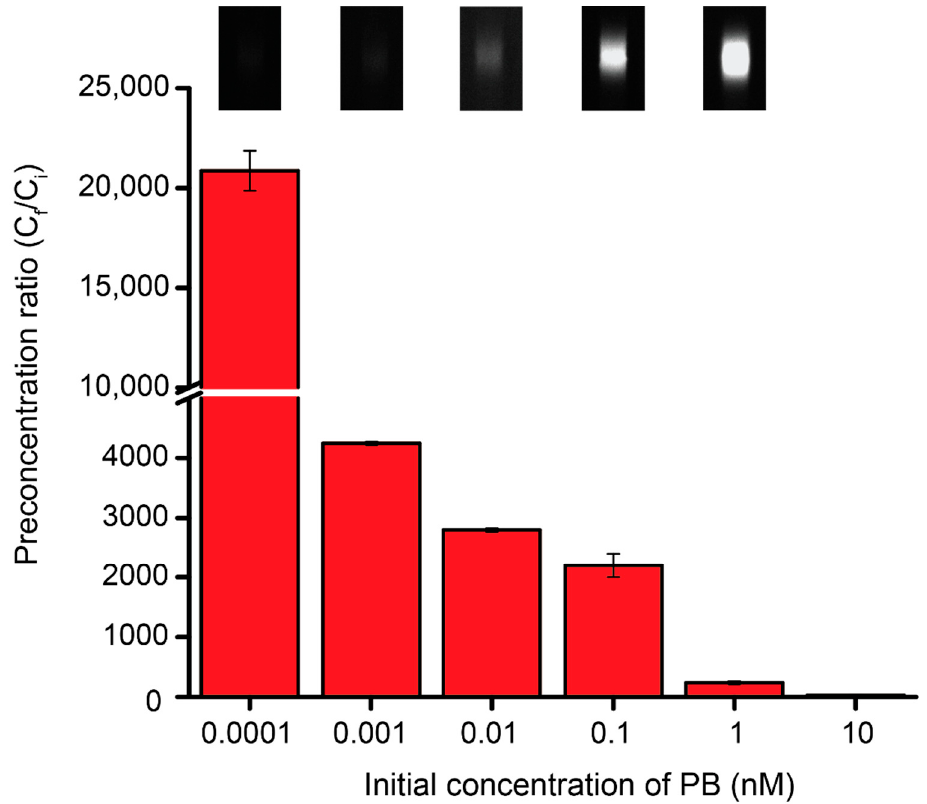
Figure 3. A plot of initial concentration of PB versus preconcentration ratio of different PB concentrations (10, 1, 0.1, 0.01, 0.001, and 0.0001 nM) prepared in 40 mM borate buffer (TE). In total, 200 mM Tris-HCl was used as the LE and 138 V/cm as the EF. Inset images show the band formed during preconcentration.